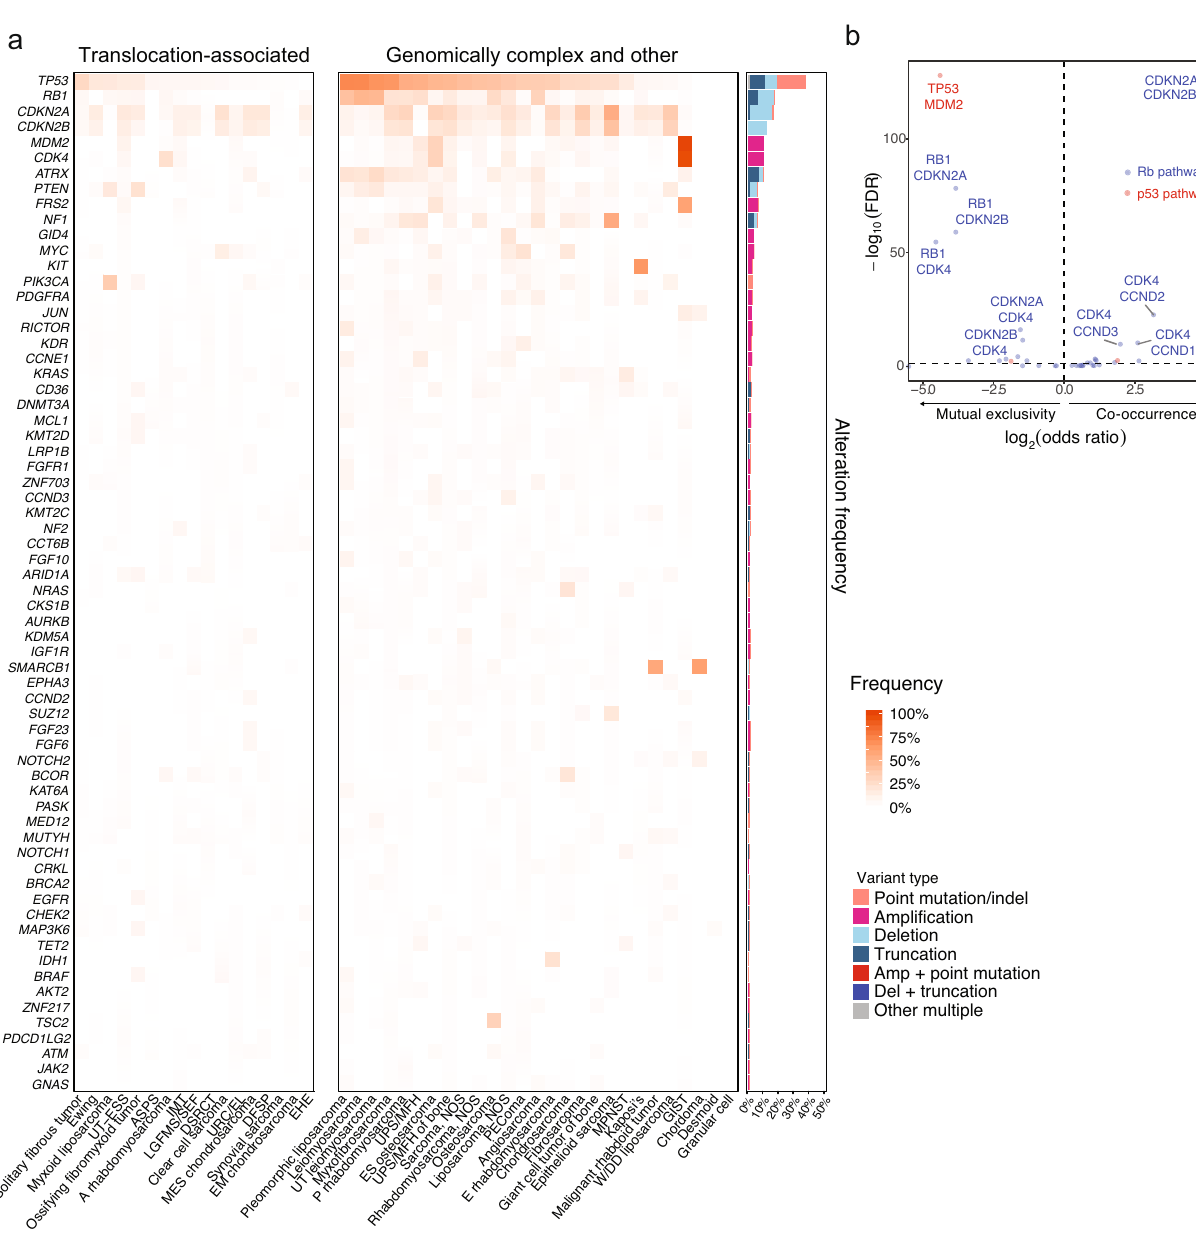
Fig. 2 Genomic landscape of sarcomas. a Heat map showing the frequency of recurrent short variants and copy number variants in the listed genes in each subtype of sarcoma, grouped as translocation-associated or genomically complex and other sarcomas (left), as well as the types of genomic alterations (right). b Volcano plot showing co-occurrence (odds ratio >1) and mutual exclusivity (odds ratio <1) between two genes within the same pathway. Top ten signi fi cant interactions (FDR < 0.05) are labeled. UT ESS uterine endometrial stromal sarcoma, ASPS alveolar soft part sarcoma, A alveolar, IMT in fl ammatory myo fi broblastic tumor, LGFMS/SEF low-grade fi bromyxoid sarcoma/sclerosing epithelioid fi brosarcoma, DSRCT desmoplastic small round cell tumor, URC/EL undifferentiated round cell/Ewing-like, DFSP dermato fi brosarcoma protuberans, EHE epithelioid hemangioendothelioma, UT uterine, P pleomorphic, UPS undifferentiated pleomorphic sarcoma, MFH malignant fi brous histiocytoma, ES extraskeletal, NOS not otherwise speci fi ed, PEComa perivascular epithelioid cell tumor, E embryonal, MPNST malignant peripheral nerve sheath tumor, W/DD well or dedifferentiated, GIST gastrointestinal stromal tumor. Source data are provided as a Source Data fi